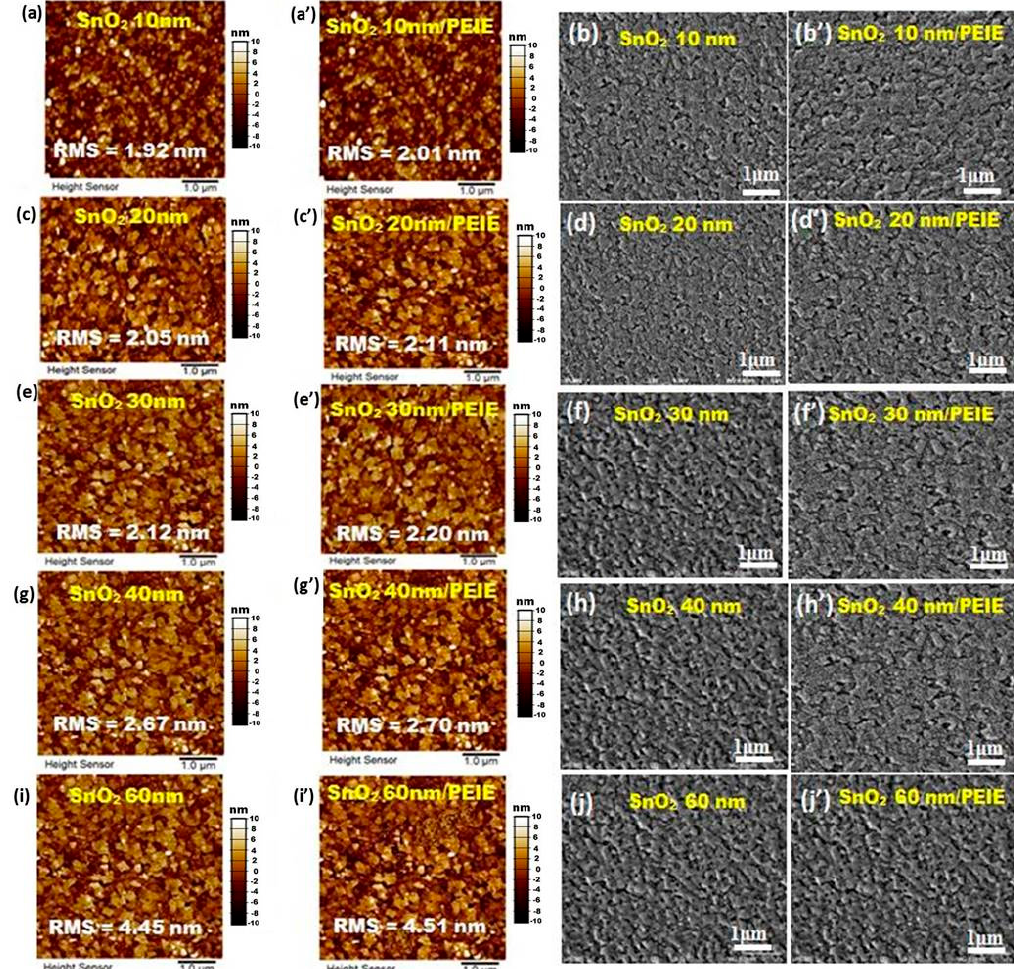
Figure 4. The 2D-AFM and SEM micrographs of sputtered SnO 2 without PEIE for 10 nm ( a , b ), 20 nm ( c , d ), 30 nm ( e , f ), 40 nm ( g , h ), 60 nm ( i , j ) and with PEIE coated on SnO 2 10 nm ( a’ , b’ ), 20 nm ( c’ , d’ ), 30 nm ( e’ , f’ ), 40 nm ( g’ , h’ ) and 60 nm ( i’ , j’ ).